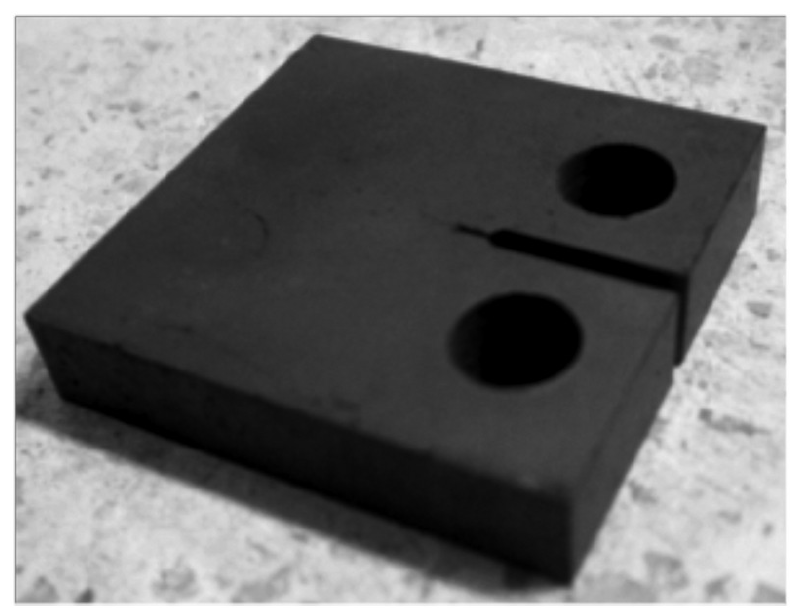
Figure 6. Test specimen for fatigue crack propagation [19].